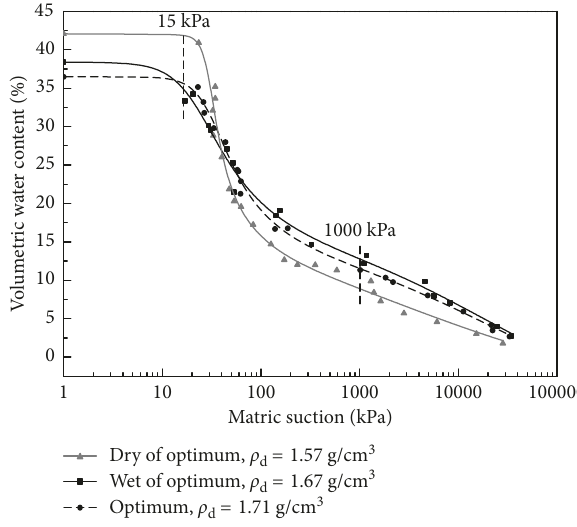
Figure 10: Drying SWCCs of specimen compacted at different initial water